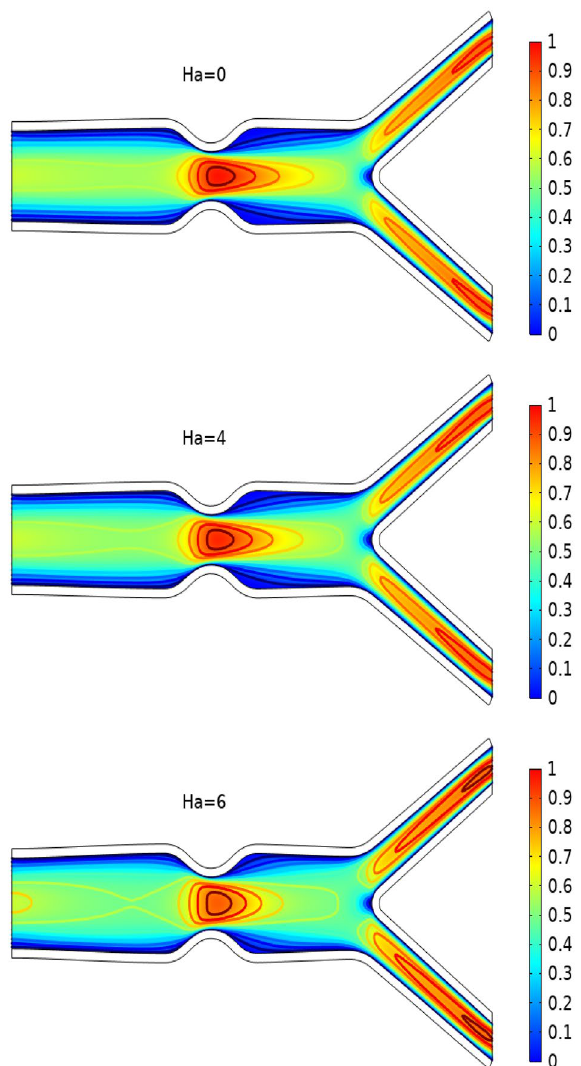
Figure 6. Velocity profile at Re = 200 for variation of Ha.